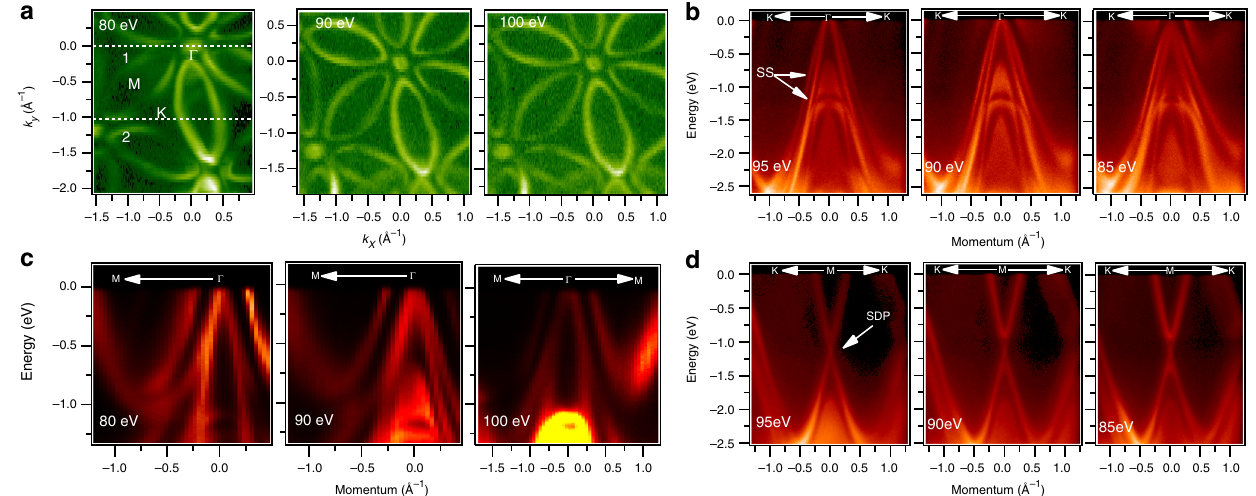
Fig. 2 Fermi surface and observation of multiple fermionic states. a Fermi surface maps at various photon energies. Photon energies are marked on the plots. The white dashed lines marking No. 1 and 2 denote the direction of the dispersion maps. b – d Dispersion maps measured along various high- symmetry directions for different photon energies. These data were collected at the SIS-HRPES end station at the SLS, PSI, at a temperature of 18